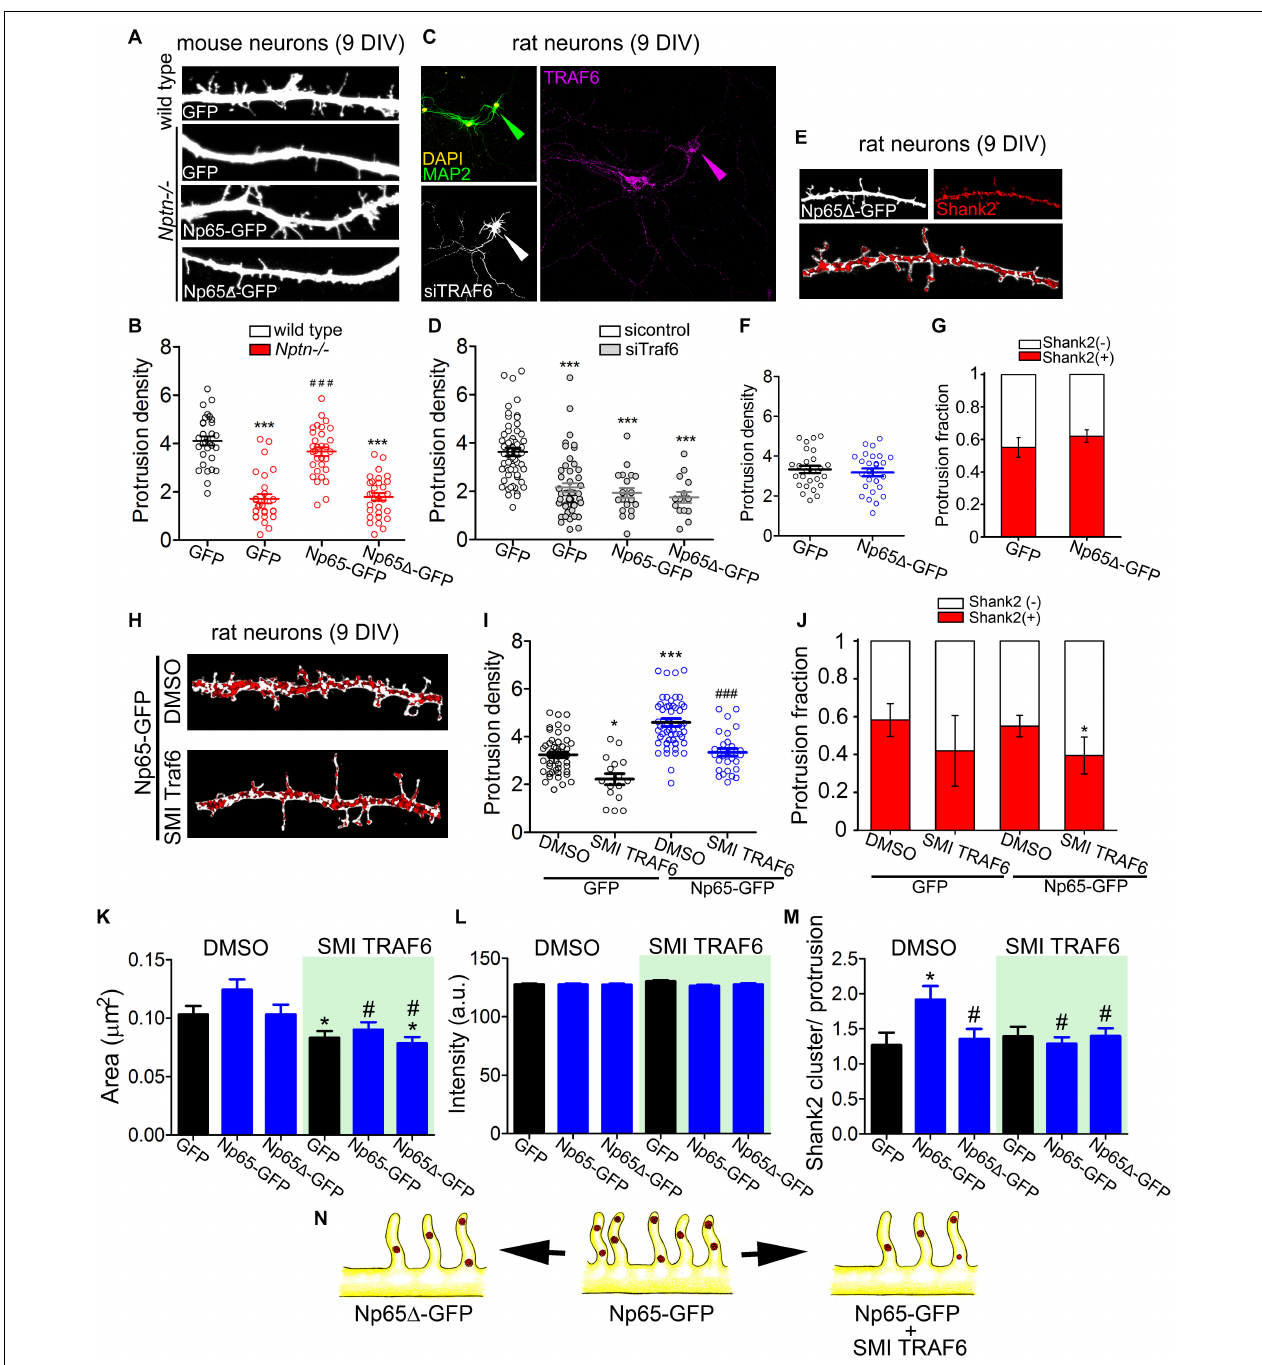
FIGURE 5 | TRAF6 mediates dendritic protrusion formation via neuroplastin. (A,B) The TRAF6 binding motif-deficient Np65 (cid:49) -GFP does not rescue dendritic protrusion formation in Nptn − / − neurons. (A) Confocal images of segments of dendrites of Nptn + / + and Nptn − / − neurons transfected with plasmids encoding GFP, Np65-GFP or Np65 (cid:49) -GFP at 7 DIV. At 9 DIV, these neurons were fixed and stained with anti-GFP antibodies followed by an Alexa 488-conjugated antibody (green). (B) Protrusion densities from 2 independent cultures were used to obtain the mean ± SEM as indicated ( Nptn + / + GFP = 4.12 ± 0.18, n = 34; Nptn − / − GFP = 1.72 ± 0.19, n = 27; Nptn − / − Np65-GFP = 3.67 ± 0.18, n = 33; Nptn − / − Np65 (cid:49) -GFP = 1.79 ± 0.16, n = 33). *** p < 0.001 vs. GFP-filled wild type neurons and ### p < 0.001 vs. GFP-filled Nptn − / − neurons using Student‘s t -test. (C,D) TRAF6 knockdown prevents the increase of dendritic protrusions induced by Np65-GFP in hippocampal neurons. Neurons were co-transfected with either control scrambled siRNA or siRNA against TRAF6 mRNA and with GFP-encoding plasmid (6 DIV). Additionally, neurons were co-transfected with siRNA and Np65-GFP or Np65 (cid:49) -GFP. After 72 h, neurons were stained with anti-MAP2